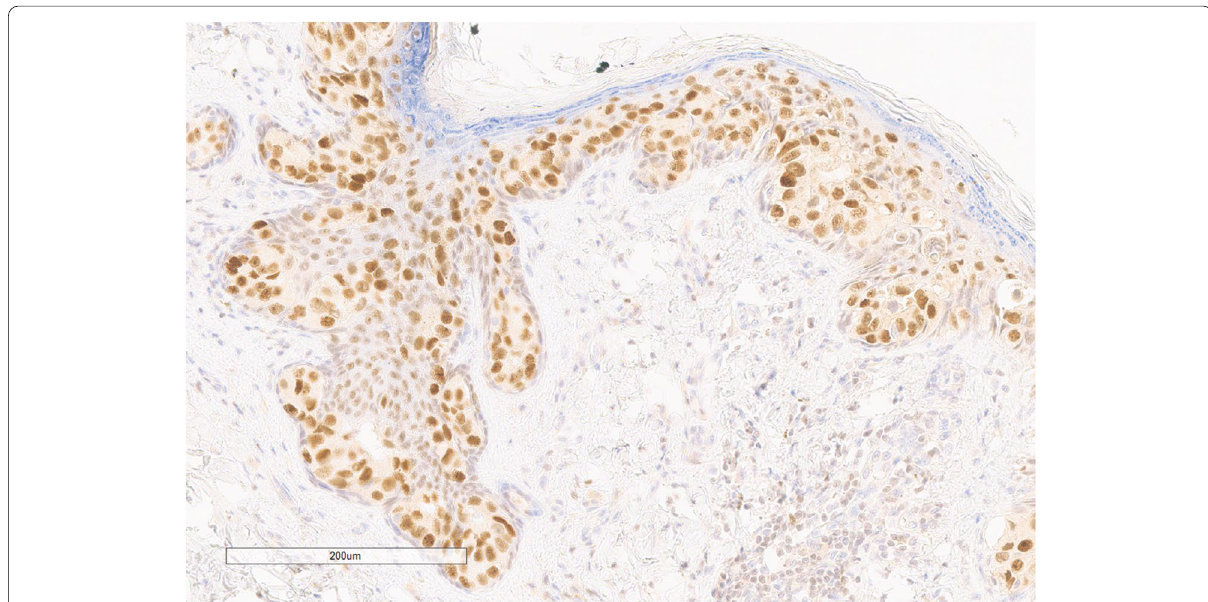
Fig. 3 Strong nuclear positive immunohistochemical staining of GATA3 in Paget’s cells